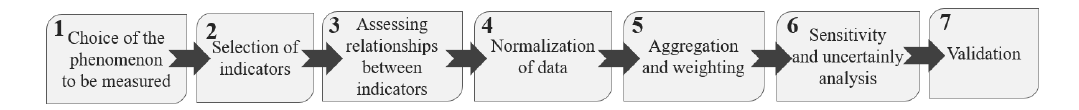
have different units of measurement (see Table 1 for the main normalization methods). By doing so, problems with outliers can also be reduced (Jacobs et al.,